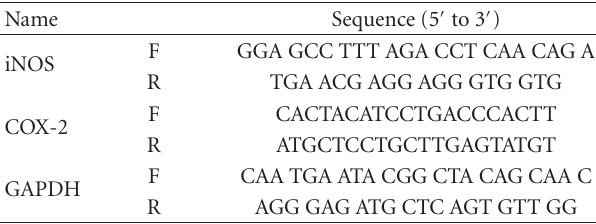
Table 1: Real-time PCR